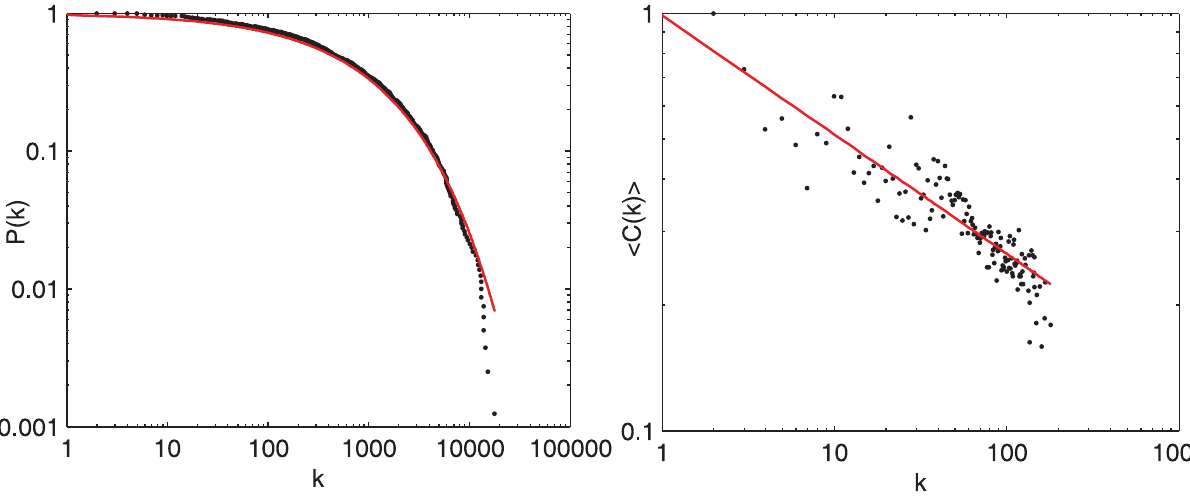
Figure 1. Measurements on the PACS network from 1977–2007. A) Cumulative degree distribution P(k) of the PACS network. The red line is a fit to the data. Both the weighted and unweighted cases follow a stretched exponential distribution. B) Average clustering vs degree for the PACS network, demonstrating that C k ð Þ has some dependence on degree. Thus, there is some hierarchical structure present in the network.